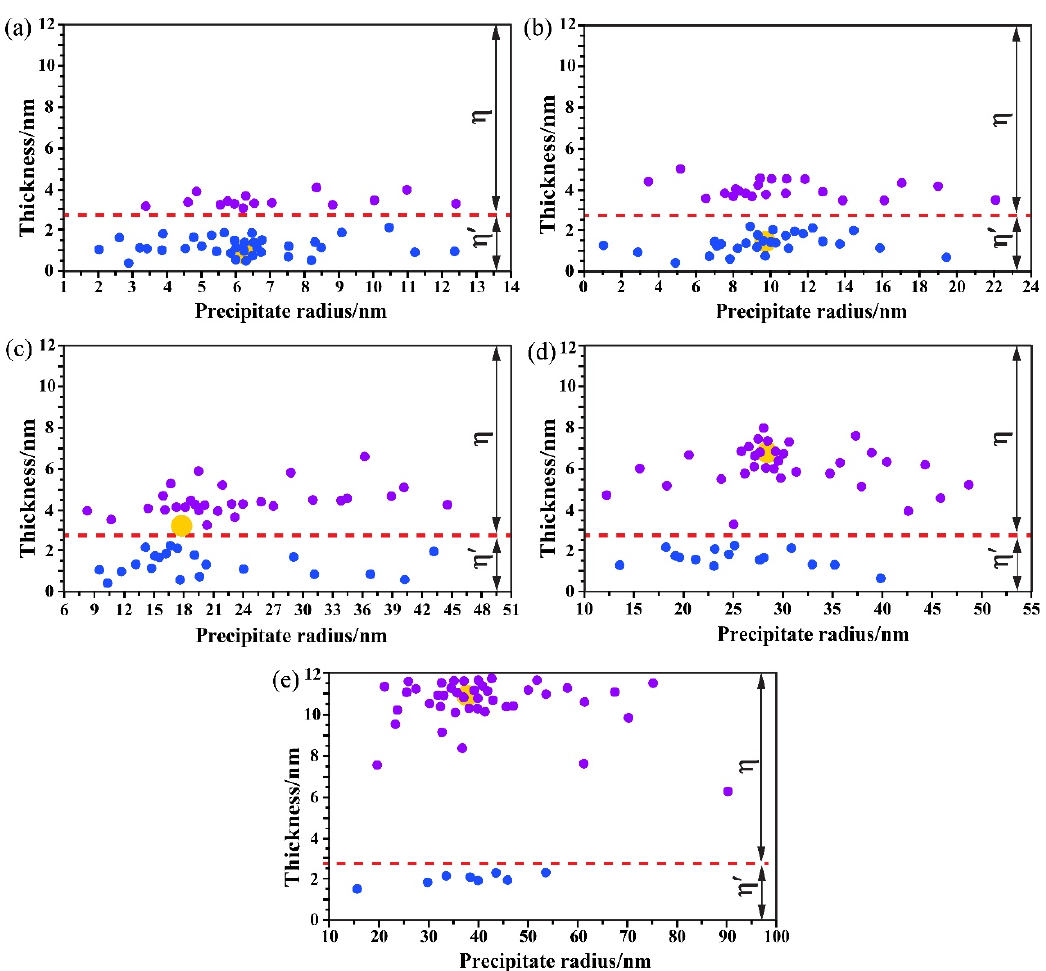
Figure 10. Distributions of the thickness versus radius of the precipitates in the 7085 alloy after various heat treatments: ( a ) sample I (25 °C), ( b ) sample II (100 °C), ( c ) sample III (125 °C), ( d ) sample IV (150 °C), and ( e ) sample V (175 °C). The orange points correspond to the average thickness and radius of the precipitates.